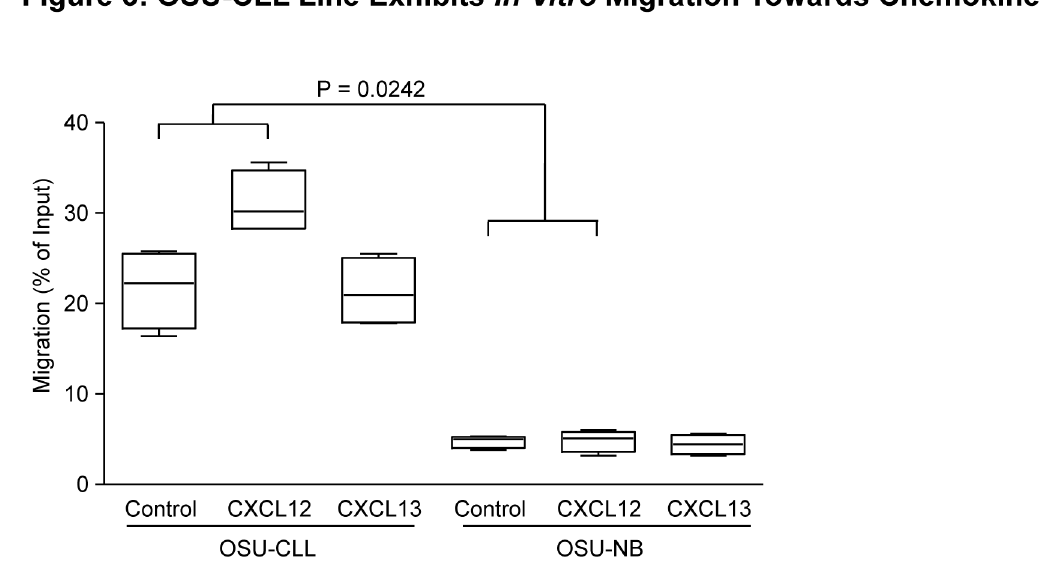
Figure 3. OSU-CLL and OSU-NB exhibit differential in vitro migration properties towards chemokine. Cells were suspended (5 x 10 6 cells/mL) and placed in the upper well of 24-well transwell plates. The bottom wells contained either media alone, or media with recombinant CXCL12 (200 ng/mL) or CXCL13 (1000 ng/mL). Cells in the lower chamber were collected after 3 hours; percent migration is calculated relative to the